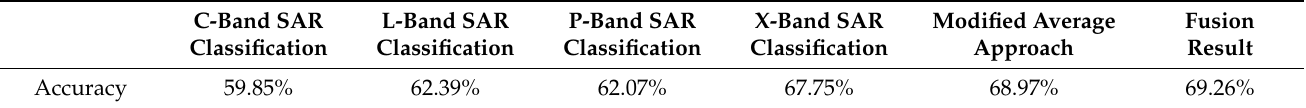
Table 2. Classification